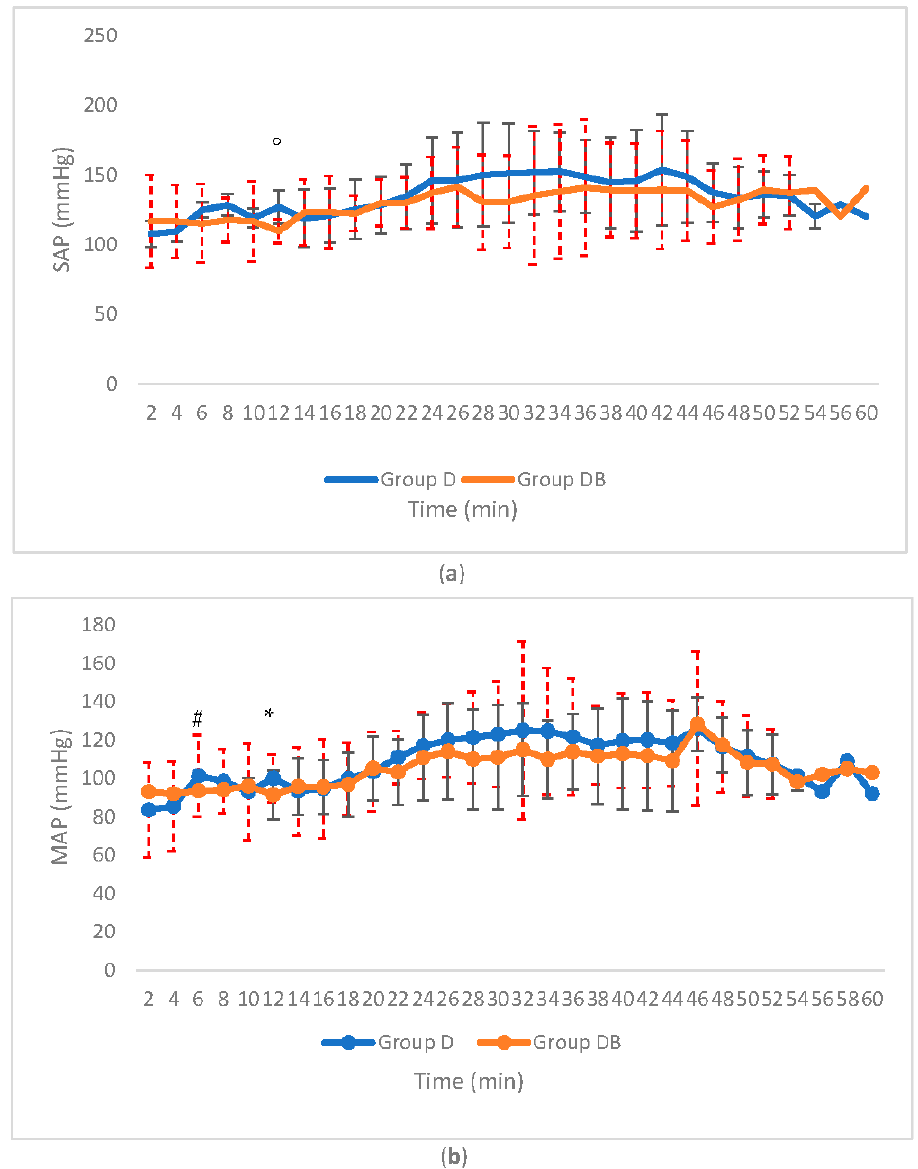
Figure 3. Line graph showing significant differences in SAP ( a ) and MAP ( b ) Statistical differences are expressed as same letter on the bars (°: p = 0.004; #: p = 0.022; *: p = 0.05). SD is displayed (SAP: Systolic Arterial Blood Pressure; MAP: Mean Arterial Blood Pressure; SD: Standard Deviation). Group D: group detomidine; Group DB: group detomidine-butorphanol.